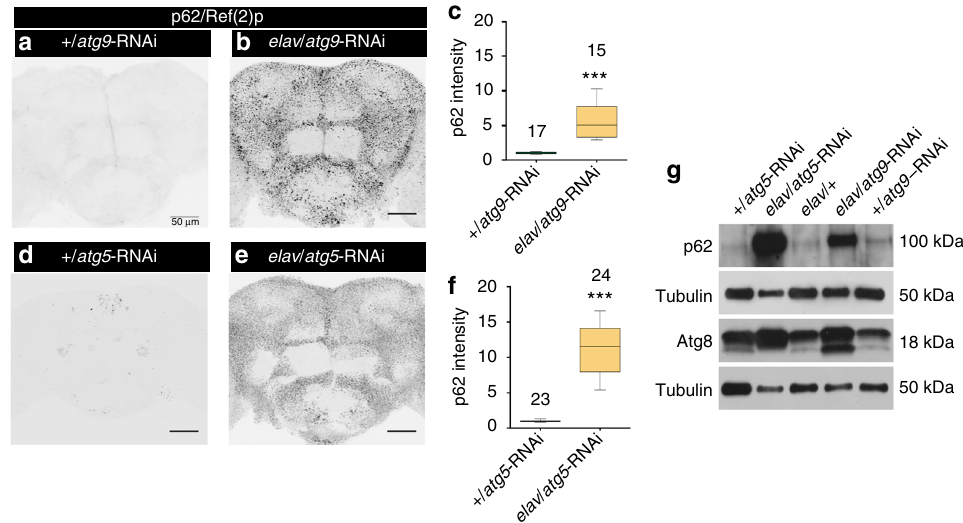
Fig. 1 Neuronal knockdown of atg9 or atg5 suppresses autophagy in the brain. Adult brain, 10 days ( a ) + / atg9 -RNAi, ( b ) elav / atg9 -RNAi, ( d ) + / atg5 - RNAi, and ( e ) elav / atg5 -RNAi immunostained for p62/Ref(2)p. Scale bar: 50 μ m. c Quanti fi cation of p62/Ref(2)p intensity within the central brain region normalized to control ( n = 15 – 17 independent brains; *** p < 0.001; Mann – Whitney U -test). f Quanti fi cation of p62/Ref(2)p intensity within the central brain region normalized to control ( n = 23 – 24 independent brains; *** p < 0.001; Mann – Whitney U -test). g Selective autophagy marker p62/Ref(2)p and autophagosome-associated protein Atg8a accumulate in protein homogenate prepared from the brain of elav / atg9 -RNA and elav / atg5 -RNAi compared to respective controls. An amount equivalent to 1 brain was loaded onto the gel. Lipidated Atg8a (Atg8a-II) is missing upon KD of atg5 but not when atg9 is knocked down. In the box and whisker plots, the middle line of a box represents the median (50th percentile) and the terminal lines of a box represent the 25th and 75th percentile. The whiskers represent the lowest and the highest